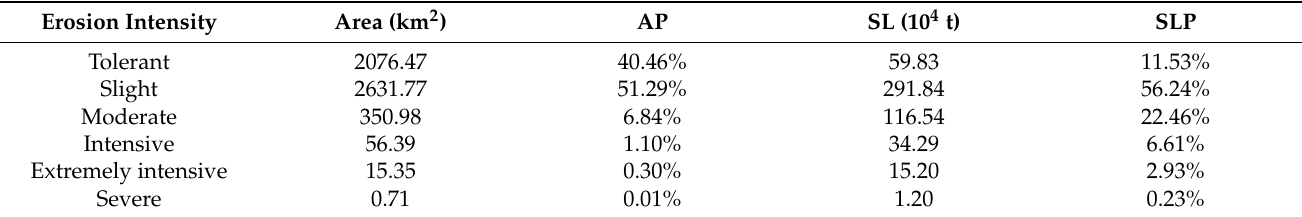
Table 4. Statistics of soil erosion intensity grades of grassland in Zhaotong.